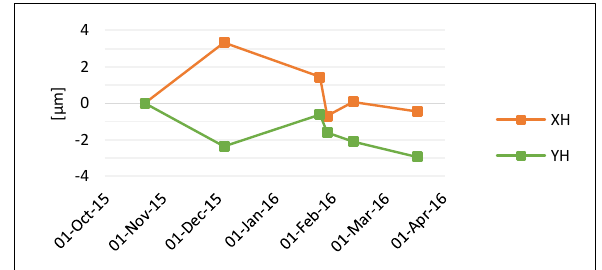
Figure 5: Motion of principal point (period of 5 month)